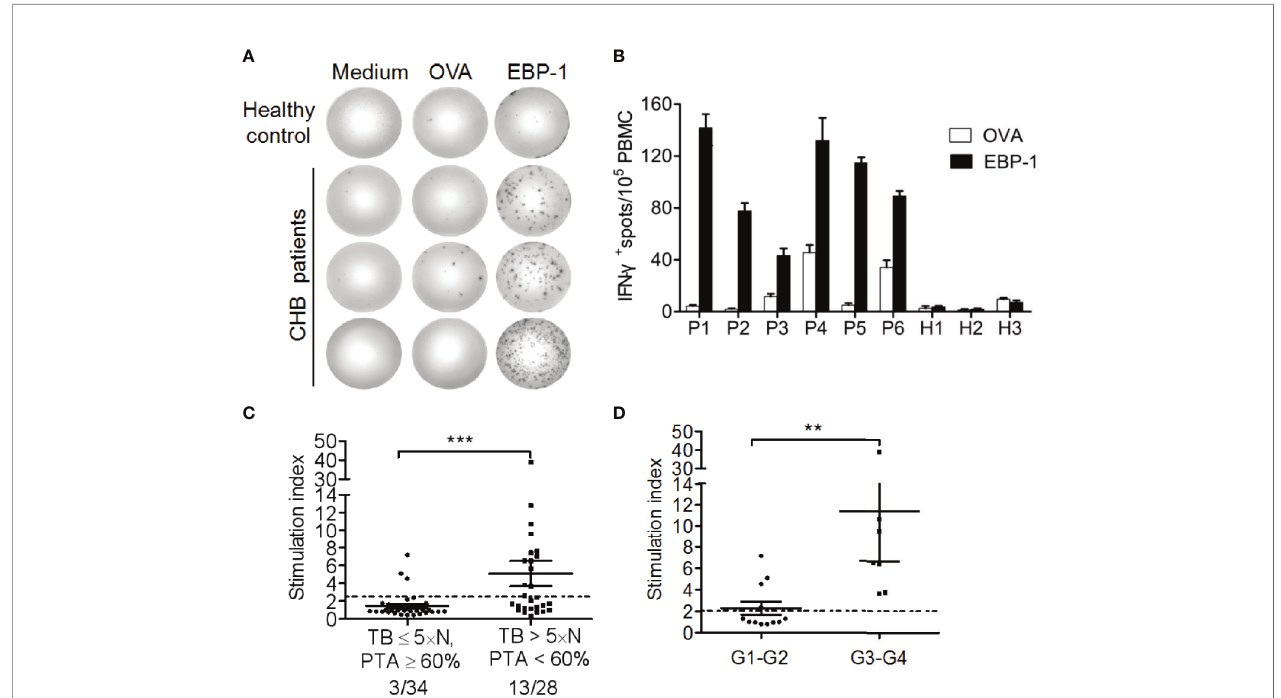
FIGURE 4 | IFN- g ELISPOT assay for detection of EBP-1-speci fi c T cell-responses. (A) Representative ELISPOT wells showing IFN- g -production by PBMCs from one HC and three CHB patients stimulated with recombinant EBP-1, OVA or medium. (B) The representative number of IFN- g + spots/1 × 10 5 PBMCs from 6 CHB patients and 3 HCs. Data are expressed as the mean ± standard deviation (SD). (C) The stimulation indexes (SI) and the percentages of positive responders were compared between patients with severe (TB > 5×N, PTA < 60%) and weak or moderate (TB ≤ 5×N, PTA ≥ 60%) liver injury. (D) The SIs were compared between patients with histological in fl ammation grade 1 – 2 (G1 – G2) and G3 – G4. Data are expressed as the mean ± SD. Signi fi cance was determined by Mann Whitney test, ** P < 0.01; *** P <